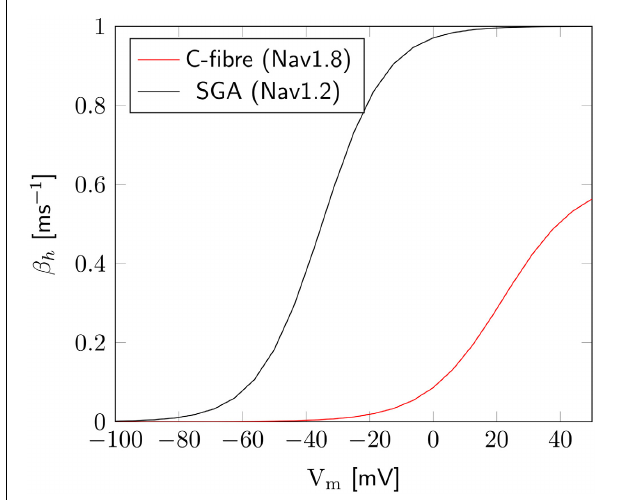
FIGURE 12 | Difference of inactivation kinetics between Nav1.2 (SGA) and Nav1.8 (C-fiber) channels. Here we plot the β h function, as defined in the m 3 h , or 8-state Na + channel model. β 1 . 8 h is much lower than β 1 . 2 h over the whole biophysically relevant